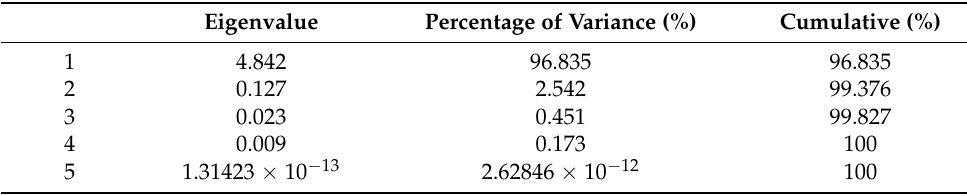
Table 6. Eigenvalues of the correlation matrix.